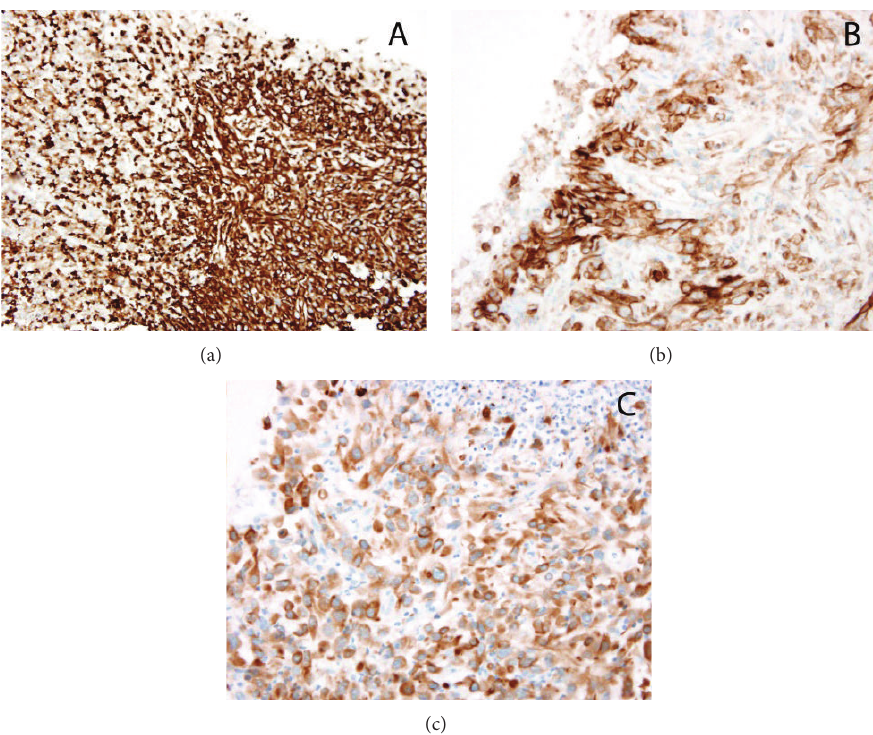
Figure 4: Spindled tumor cell cytoplasm is positive for (a) vimentin, (b) CD10, and (c) AE1/AE3 and negative for EMA, CD31, RCC, and desmin supporting the diagnosis of sarcomatoid renal cell